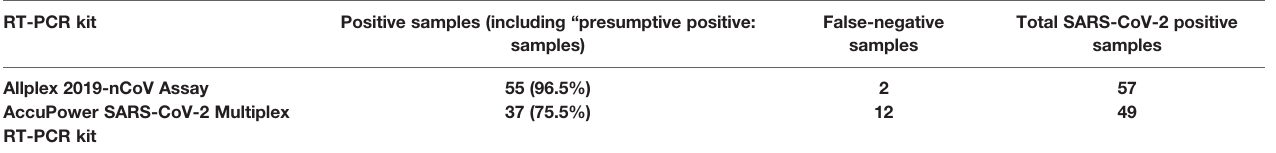
TABLE 1 | Clinical performance of AccuPower SARS-CoV-2 Multiplex RT-PCR kit and Allplex 2019-nCoV Assay using the CDC protocol as a gold standard (% values: